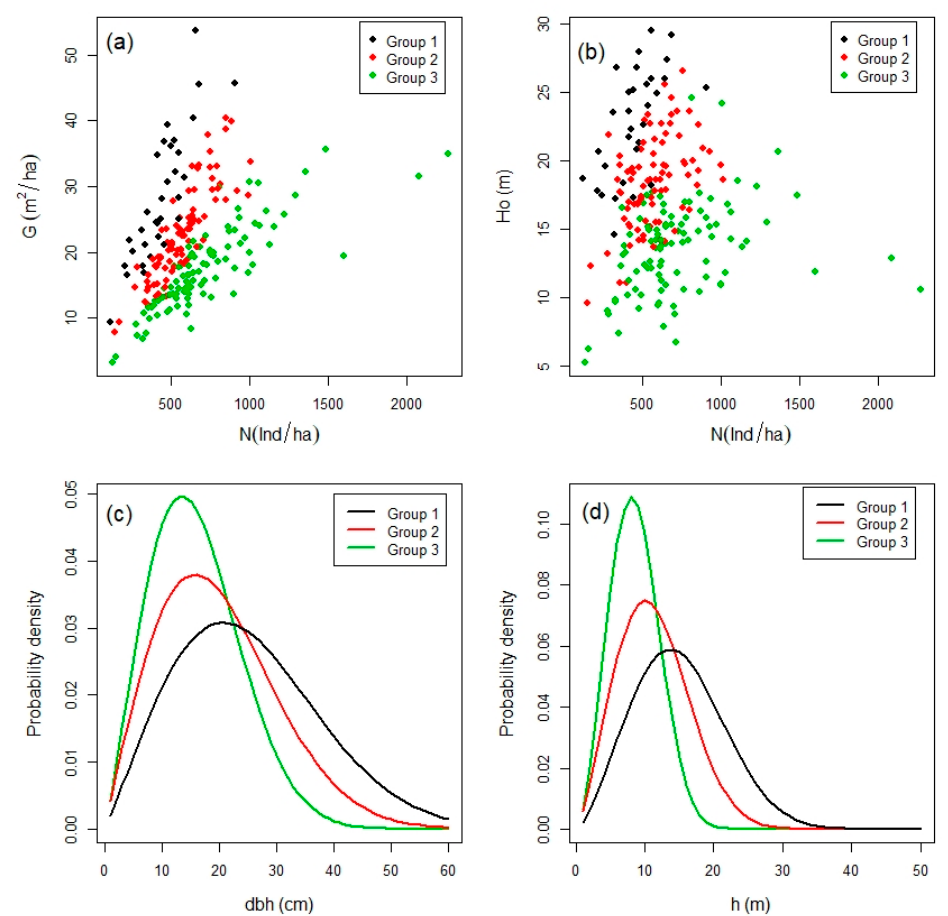
Figure 2. Four characteristics of the three groups of plots. ( a ) The relationship between number of trees (N) and basal area (G); ( b ) the relationship between number of trees (N) and dominant height (Ho); ( c ) the diameter distributions; and ( d ) the height distributions.